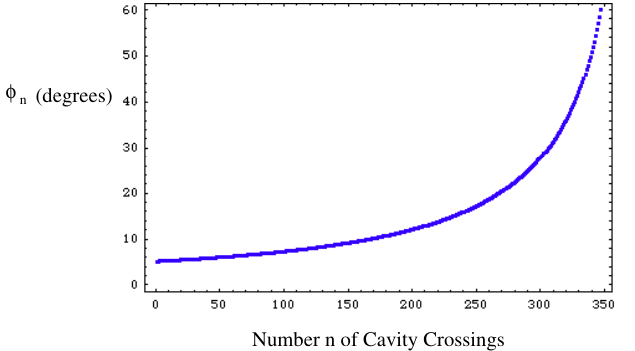
FIG. 6. (Color) rf phase (cid:1)